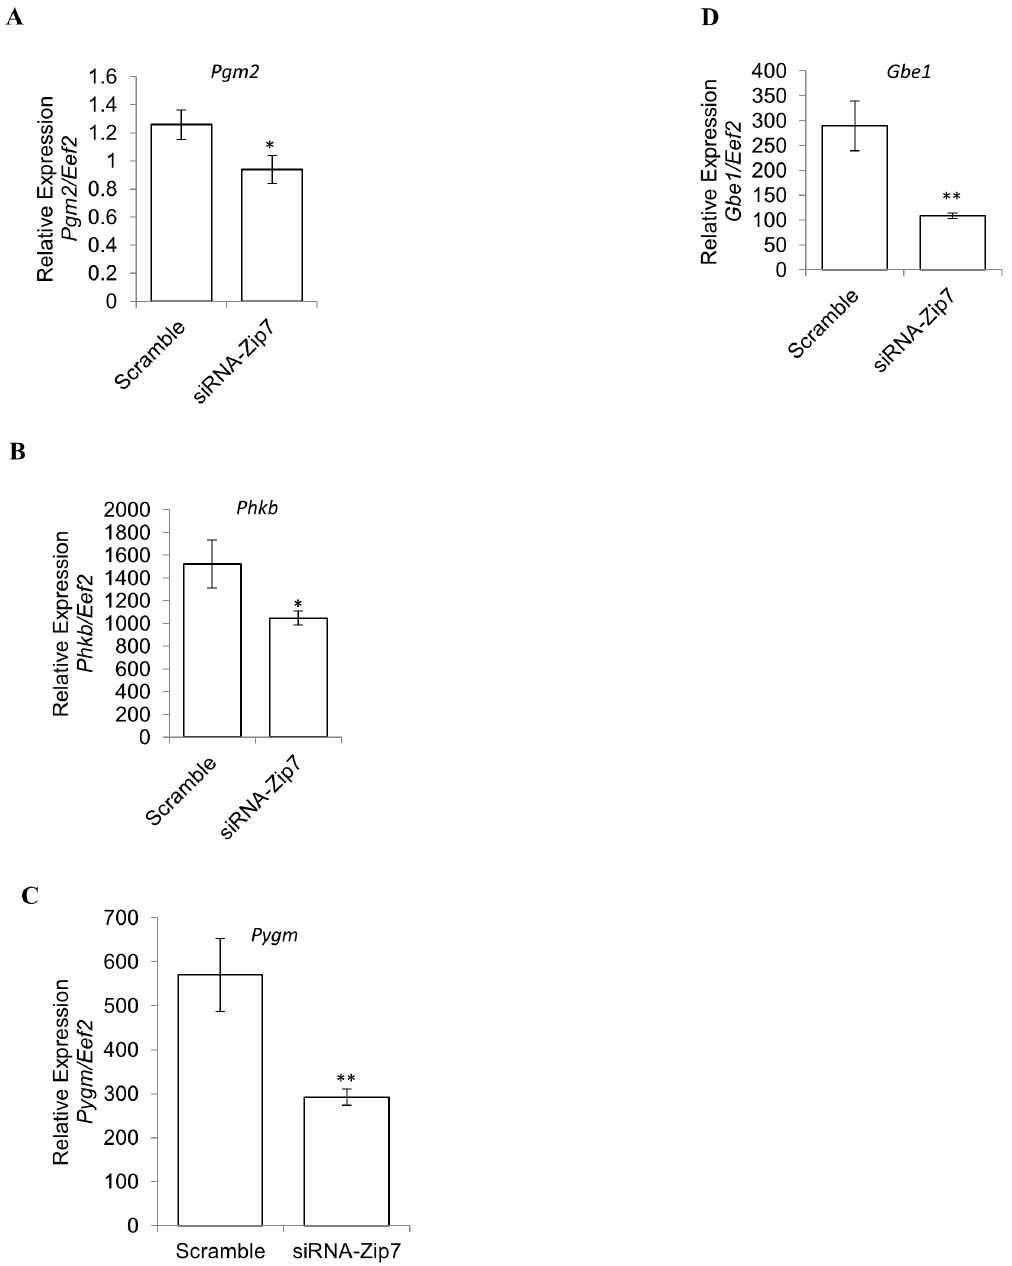
Figure 5. Reduced Zip7 expression alters gene expression of key glucose metabolic genes. A–E). Relative expression of Pgm2, Phkb, Pygm and Geb1 mRNA to Eef2 in the scramble control and the siRNA-Zip7, respectively. Error bars indicated the 6 SD from three independent biological samples. * P , 0.05, ** P , 0.01.